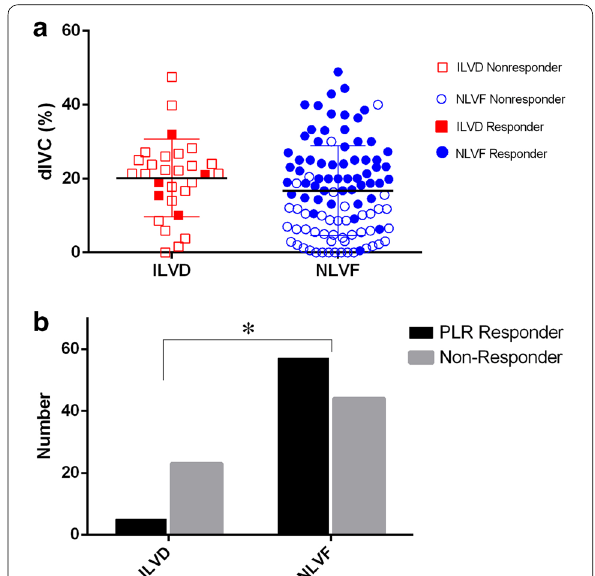
Fig. 2 Distribution of dIVC and proportion of PLR responders in ILVD and NLVF patients. a There was no difference in dIVC value between ILVD and NLVF patients, p 0.211. b ILVD patients had much lower = proportion of PLR responders than that in NLVF patients, p < 0.001. ILVD isolated left ventricular systolic dysfunction, NLVF normal left ventricular function, dIVC inferior vena cava distensibility index, PLR passive leg raising